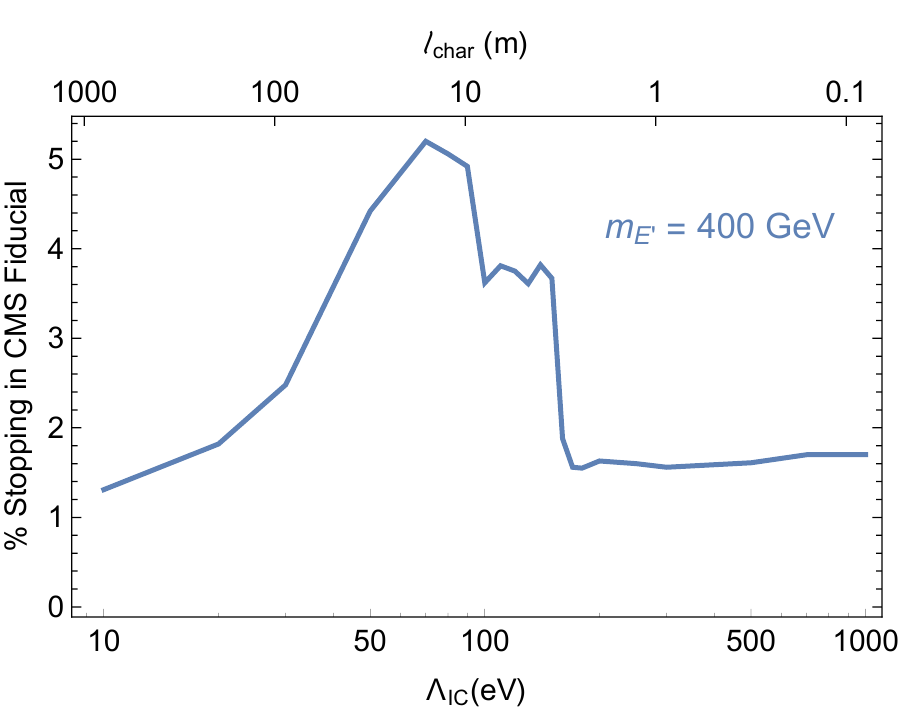
Figure 2 . Percentage of E 0 -like quirk pairs that stop within the (cid:12)ducial region of the CMS out- of-time search (ECal and HCal with j (cid:17) j < 1 : 0) for m E 0 = 400 GeV. Above (cid:3) IC (cid:24) 100 (150) eV, the quirks no longer have a terminal velocity in the ECal (HCal), reducing the likelihood to stop. The characteristic separation length eq. (1.1) is shown above.